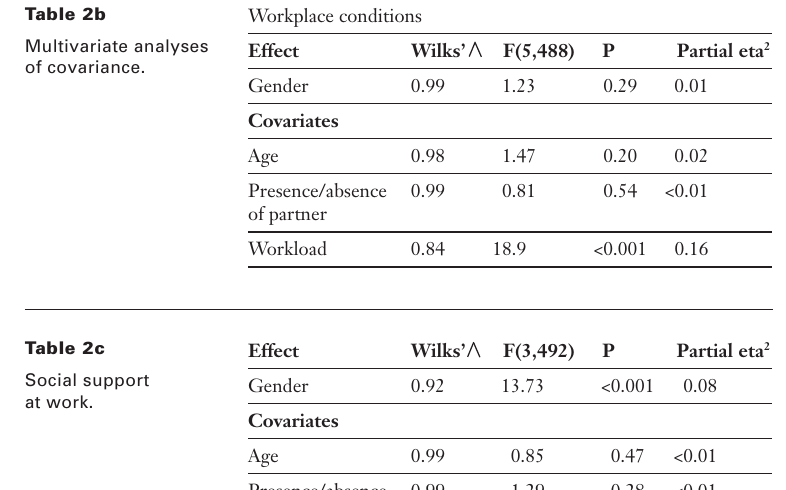
Social support at work.